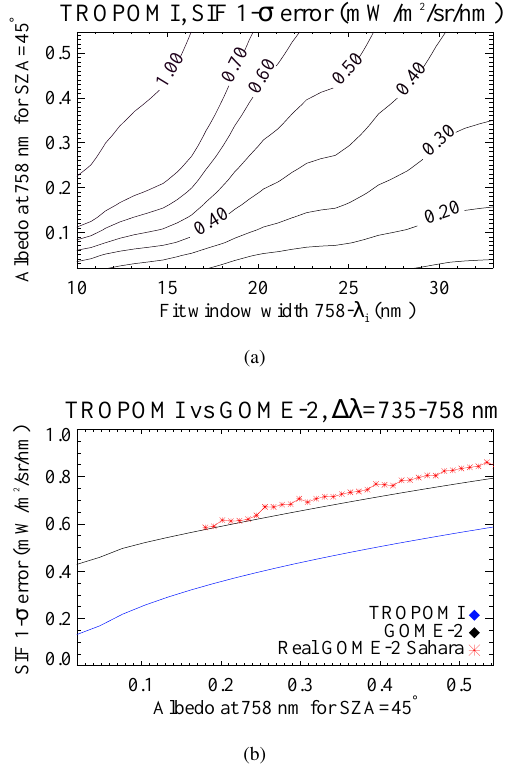
Figure 7. Simulated precision of SIF retrieval from TROPOMI as Fig. 7: Simulated precision of SIF retrieval from TROPOMI a function of surface albedo at 758nm for the reference sun zenith as a function of surface albedo at 758 nm for the reference angle (SZA) of 45 ◦ . The dependence on the width of the spectral sun zenith angle (SZA) of 45 ◦ . The dependence on the width fitting window in the range between 725 and 758nm is displayed of the spectral fitting window in the range between 725 and in (a) , and the comparison with GOME-2 for the 735–758nm fitting 758 nm is displayed in (a), and the comparison with GOME- window is shown in (b) . The standard deviation calculated from real 2 for the 735–758 nm fitting window is shown in (b). The GOME-2 SIF retrievals in the same fitting window over the Sahara standard deviation calculated from real GOME-2 SIF re- desert (15–30 ◦ N, − 5–30 ◦ E) is also trievals in the same fitting window over the Sahara desert (15 ◦ –30 ◦ N, -5 ◦ –30 ◦ E) is also plotted.